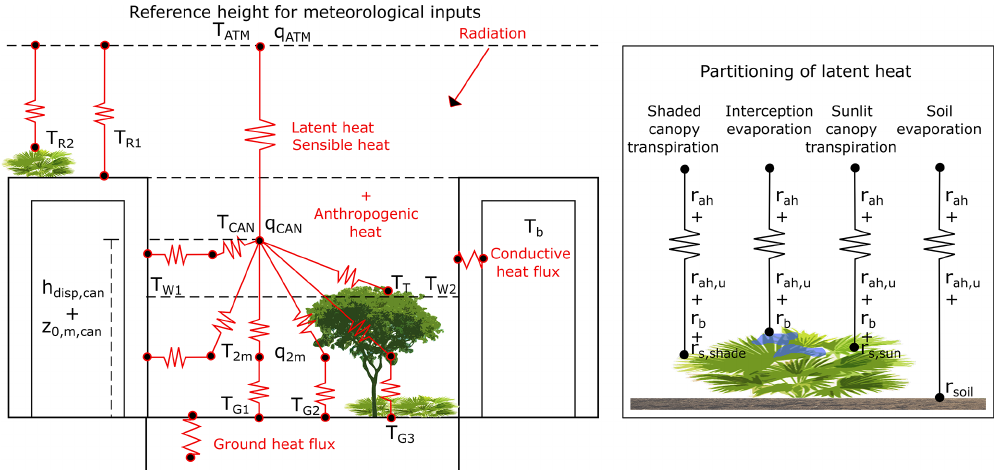
Figure 2. Modelled energy fluxes in UT&C. T R ,i , T W ,i , T G ,i , and T T are the roof, wall, ground, and tree temperatures, which are calculated solving the individual surface energy balances. The canyon air is subdivided into two layers, and air temperature and humidity are calculated at 2m height ( T 2m , q 2m ) and at the canyon reference height ( T can , q can ), which is equal to the sum of zero-plane displacement height ( h disp,can ) and momentum roughness length ( z 0,m,can ) of the canyon. T atm and q atm are the air temperature and humidity at the reference height for meteorological inputs, and T b is the prescribed interior building temperature. The graph on the right shows the resistances applied to calculate shaded and sunlit canopy transpiration, evaporation from interception, and soil evaporation within the urban canyon. r s,shade is the stomatal resistance of shaded vegetation canopy, r s,sun the stomatal resistance of sunlit vegetation canopy, r b the leaf boundary resistance, r soil the soil resistance, r ah,u the vertical aerodynamic resistance within the canyon, and r ah the aerodynamic resistance above the urban